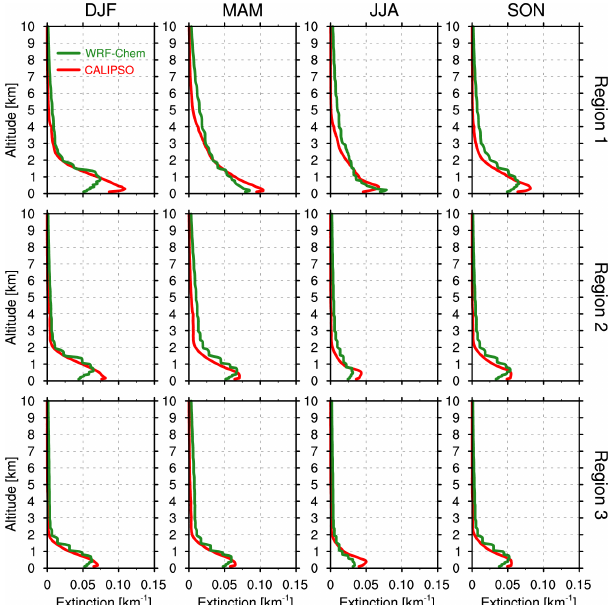
Figure 13. Vertical distributions of seasonal mean aerosol extinc- tion from the CALIPSO retrieval and the corresponding WRF- Chem simulation averaged for the period 2010–2014 over three sub- regions as shown in Fig.